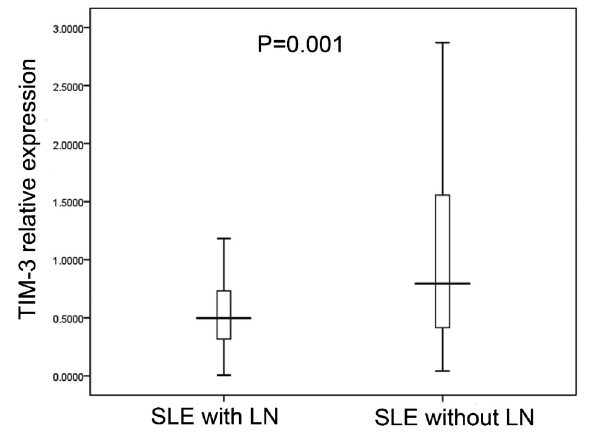
Figure 2. TIM-3 mRNA expression levels in peripheral blood mononuclear cells from systemic lupus erythematosus (SLE) patients with and without lupus nephritis (LN). Data are reported in box plots as medians and quartiles. P=0.001, SLE patients with LN (n=52) compared to SLE patients without LN (n=80) (Mann-Whitney test).